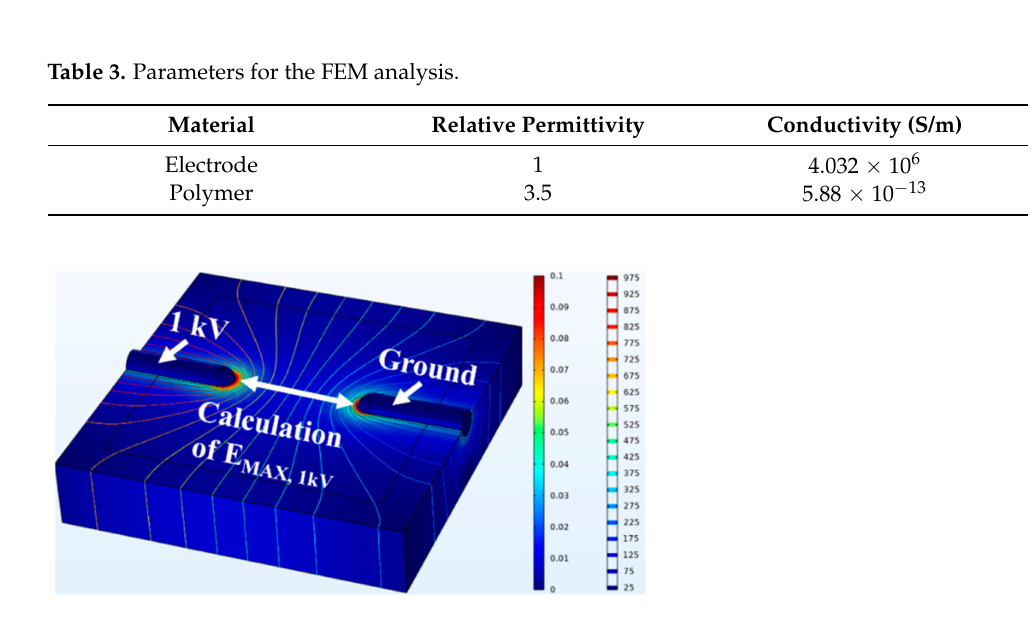
Figure 3. Distribution on E MAX, 1 kV of the polymer